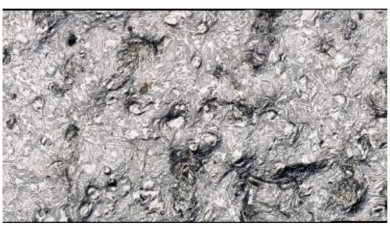
Figure 15. Surface quality CB20B, magnification 500 × .